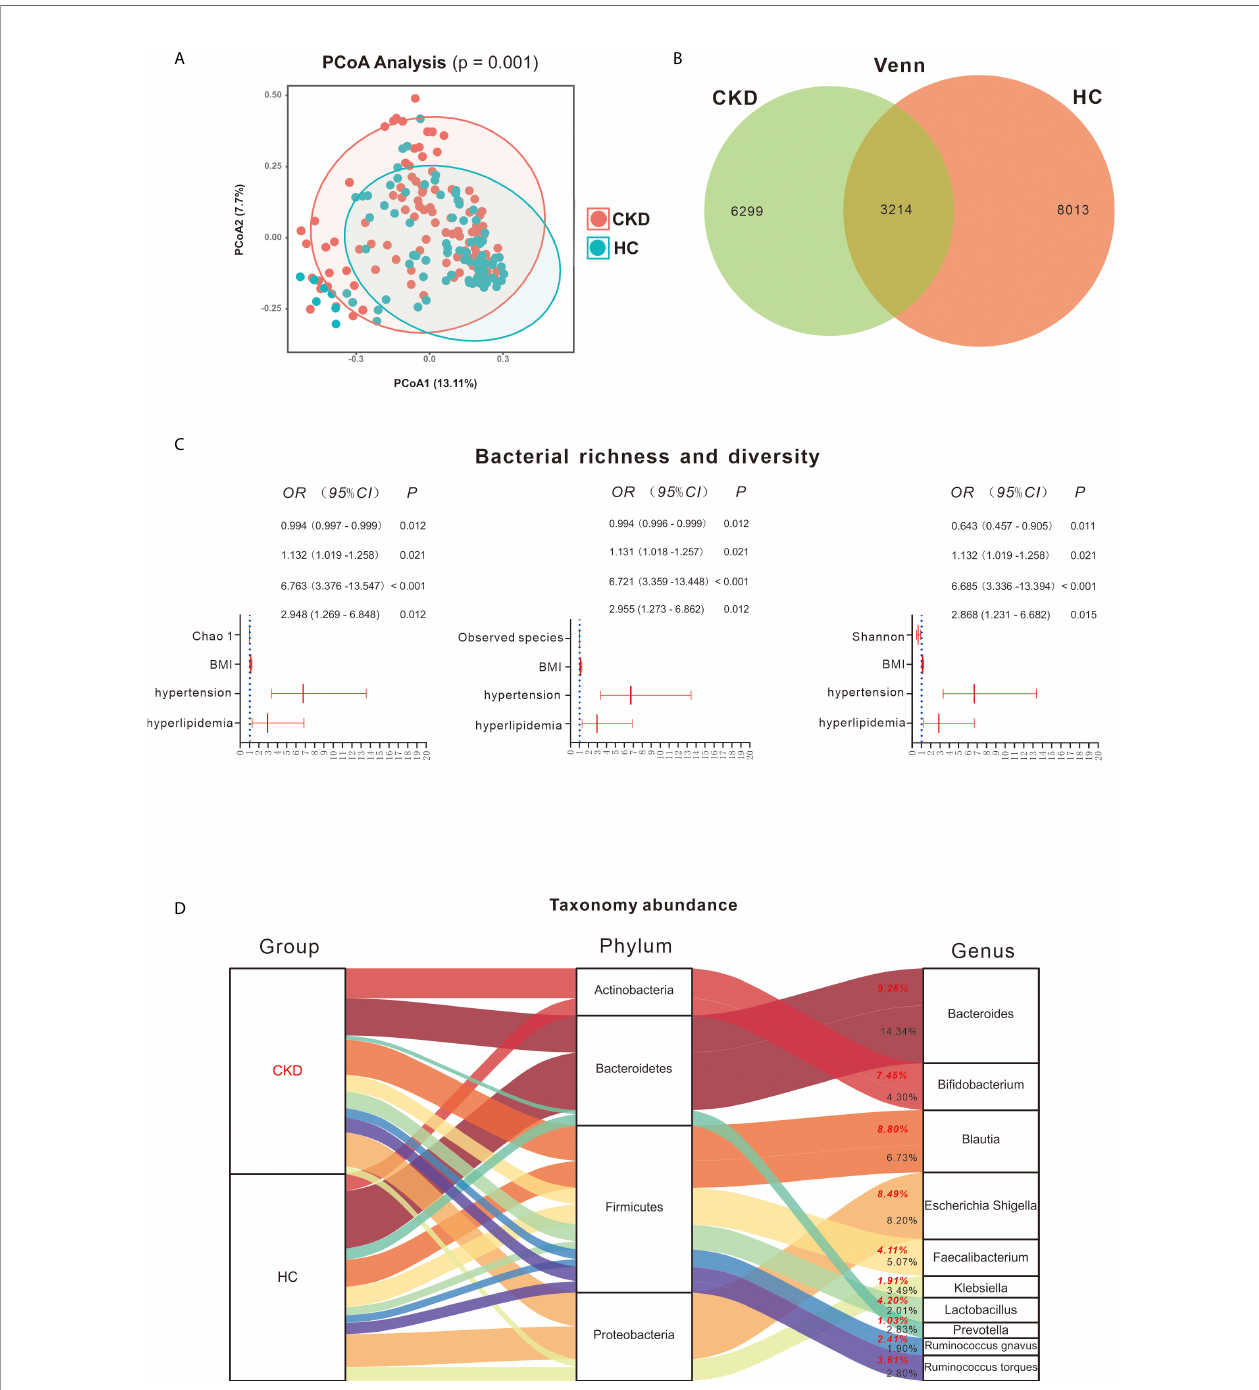
FIGURE 1 | Bacterial community, diversity and pro fi le. (A) Principal coordinates analysis (PCoA) revealed clustering of bacterial taxa in the CKD and HC groups based on Bray – Curtis distance, with each point corresponding to a subject and colored according to the sample type. Permutational multivariate analysis of variance showed that the separation of bacterial communities in the CKD and HC cohort was signi fi cant ( P = 0.001). (B) Venn diagram showing the shared number of operational taxonomic units by CKD and HC subjects. (C) Bacterial richness and diversity between the CKD and HC cohorts. Binary regression analysis was used to adjust for confounders of BMI, hypertension and hyperlipidemia. The estimated ORs and their CIs are displayed as forest graphs. The blue dotted line represents the OR value = 1. Comparison of gut microbiome richness and diversity shows that lower Chao 1, observed species and Shannon indices can predict the prevalence of CKD ( P < 0.05). (D) Bacterial pro fi le in the CKD and HC groups. Red font represents the CKD group and the bacterial abundance in this group; black font represents the HC group and the bacterial abundance in this